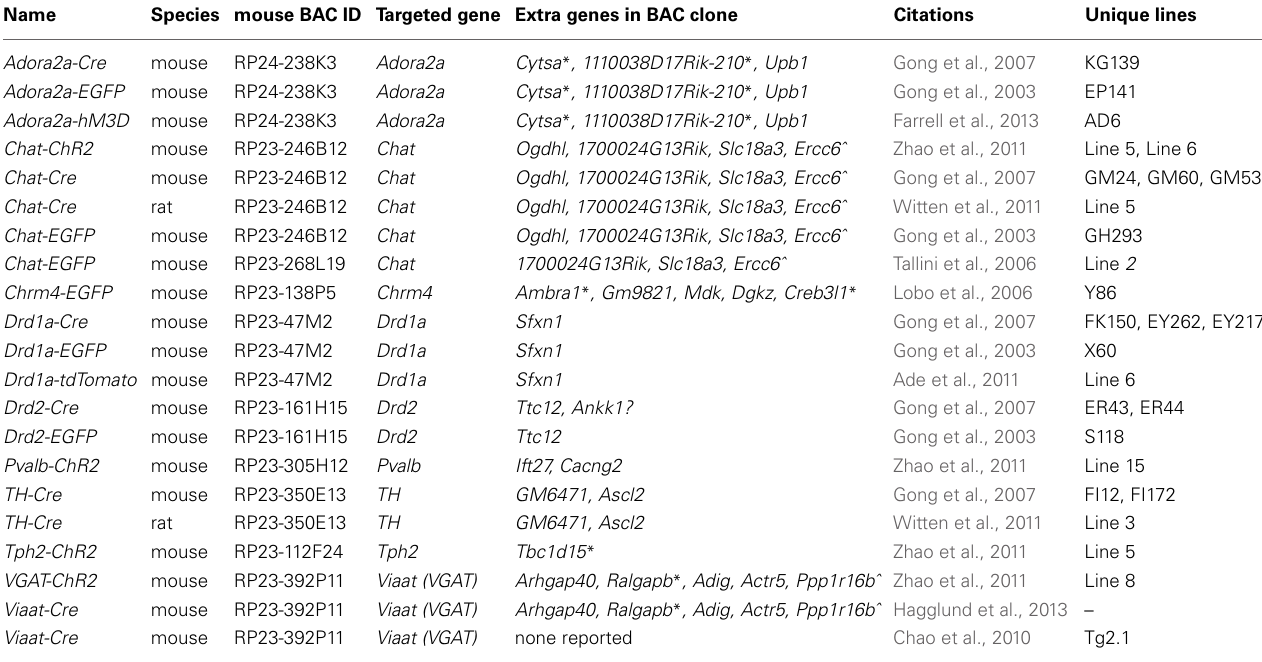
Table 1 | BAC transgenic lines typically have increased gene dosage of one or more extra gene.